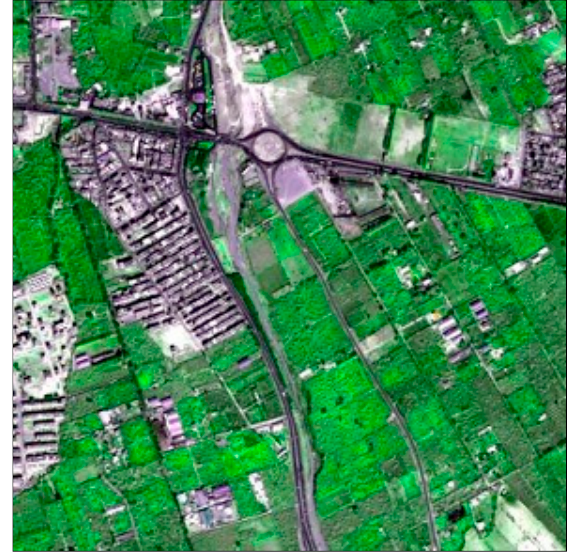
Figure 3. IKONOS satellite image for the Shahriar region (Tehran), 2013, which has 4 spectral bands, Red, Green, Blue and Near Infrared with a spatial resolution of 4 meters and a size of 400 × 400 pixels. In HDCA, the gravitational constant (G) for traveling operator was considered equal to 10 with the lapse of time. The maximum number for escaping operator was set to 100, and the number of iterations set to 3. It should be noted that the distance vectors in four main directions with the length of a pixel ((1,1) (0,1) (1,0) ( − 1,1)) for the Co-occurrence Matrix [62] were considered. The feature of inertia